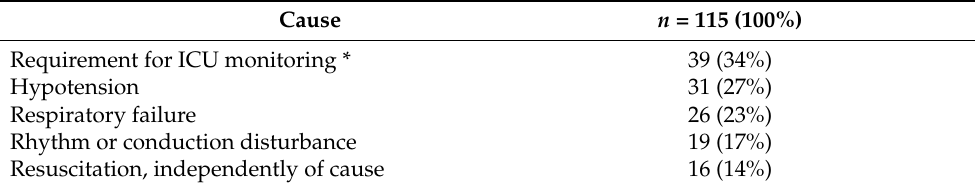
Table 4. High-severity adverse event causes. Cause n = 115 (100%) Requirement for ICU monitoring * 39 (34%)